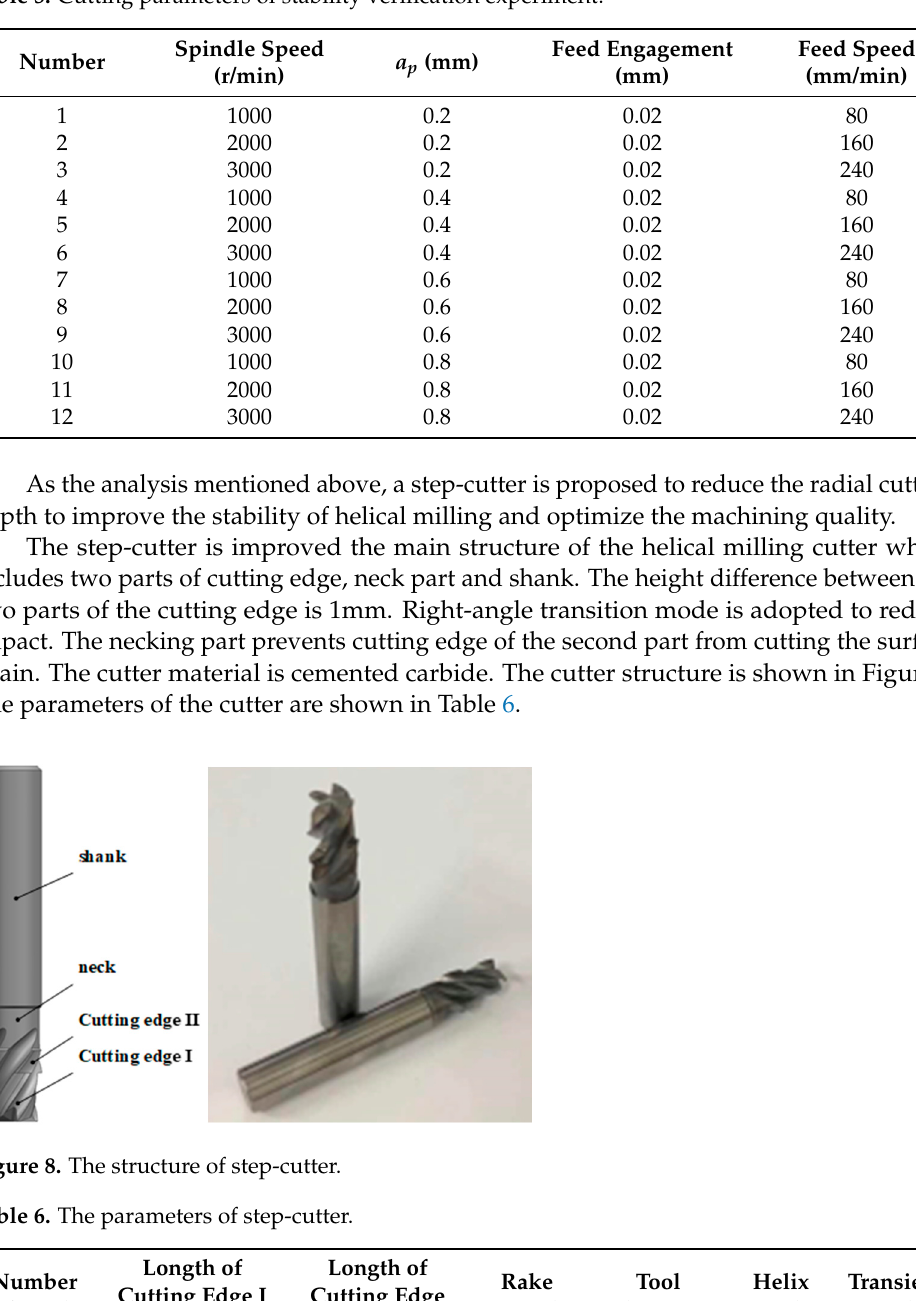
Table 5. Cutting parameters of stability verification experiment.